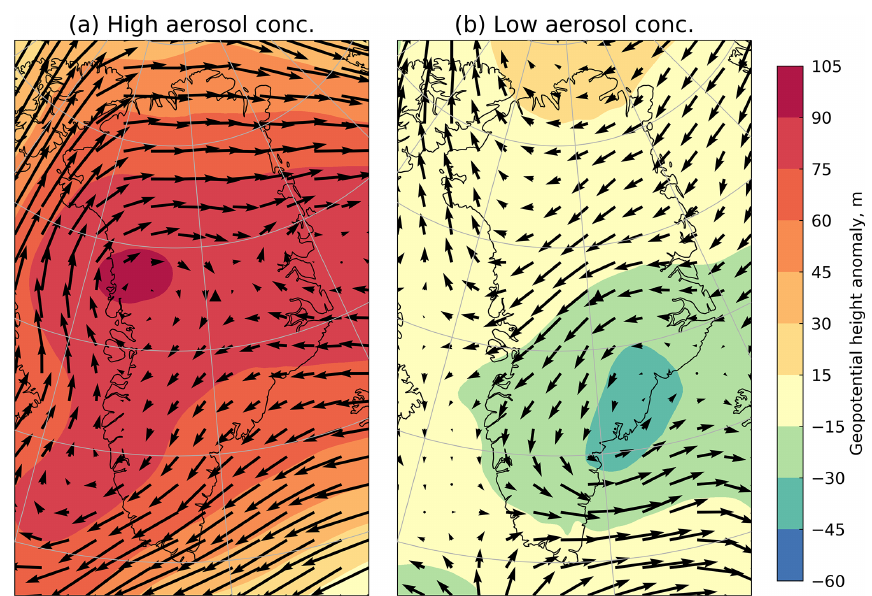
Figure 8. ERA5 mean 500hPa geopotential height anomaly (shaded) and 500hPa horizontal wind anomalies (barbed) for all high- N 20 events (a) and low- N 20 events (b) .